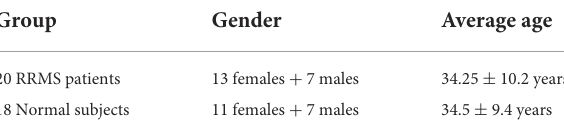
TABLE 1 The gender and the average age of participants. Group Gender Average age